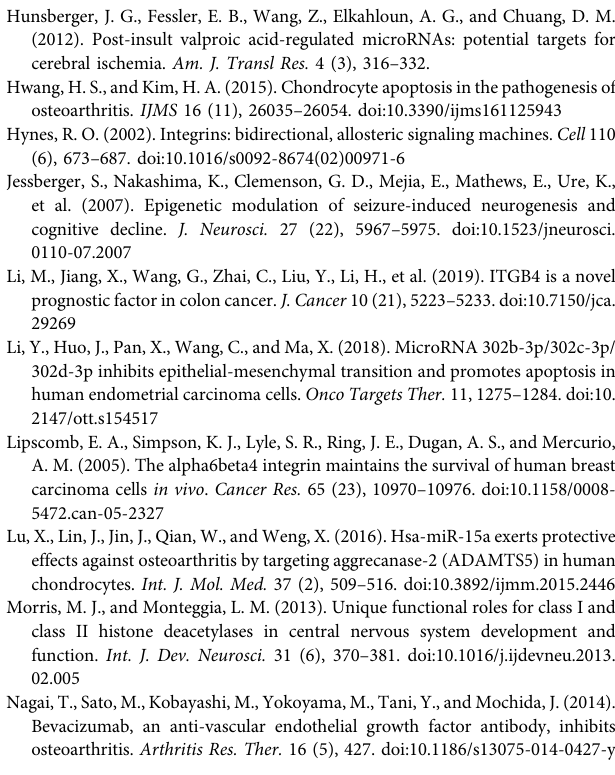
Supplementary Figure 1 Two replicates of western blot